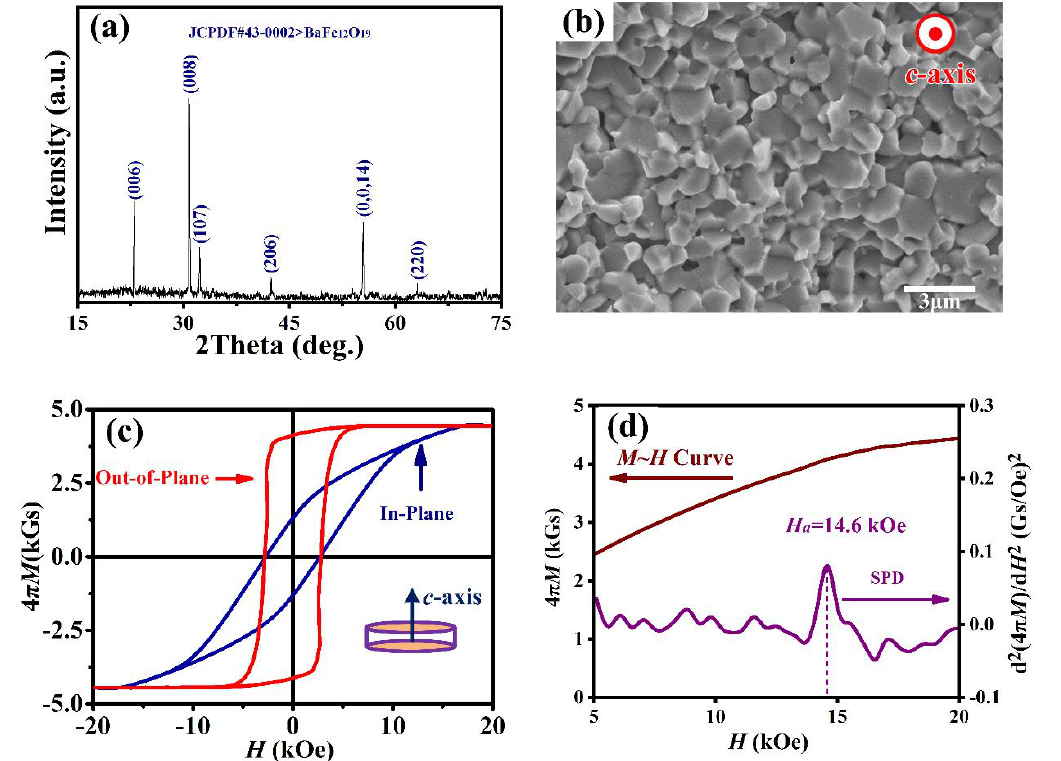
Figure 2. ( a ) X-ray diffraction pattern from Ba 0.8 La 0.2 Fe 11.8 Cu 0.2 O 19 sample illustrating strong crystallographic texture. ( b ) Scanning electron microscopy image revealing a dense cross-sectional microstructure of faceted crystals. ( c ) Hysteresis loops collected with the applied magnetic field aligned perpendicular to and in-plane with the sample plane. ( d ) Initial magnetization curve and second derivative d 2 (4π M )/d H 2 curve measured perpendicular to the direction of easy magnetization.